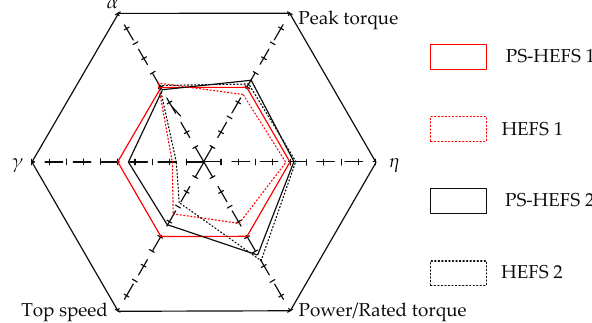
Figure 18. Comparison of six key performances of the four machines. Table 4. Key performances comparison among four machines